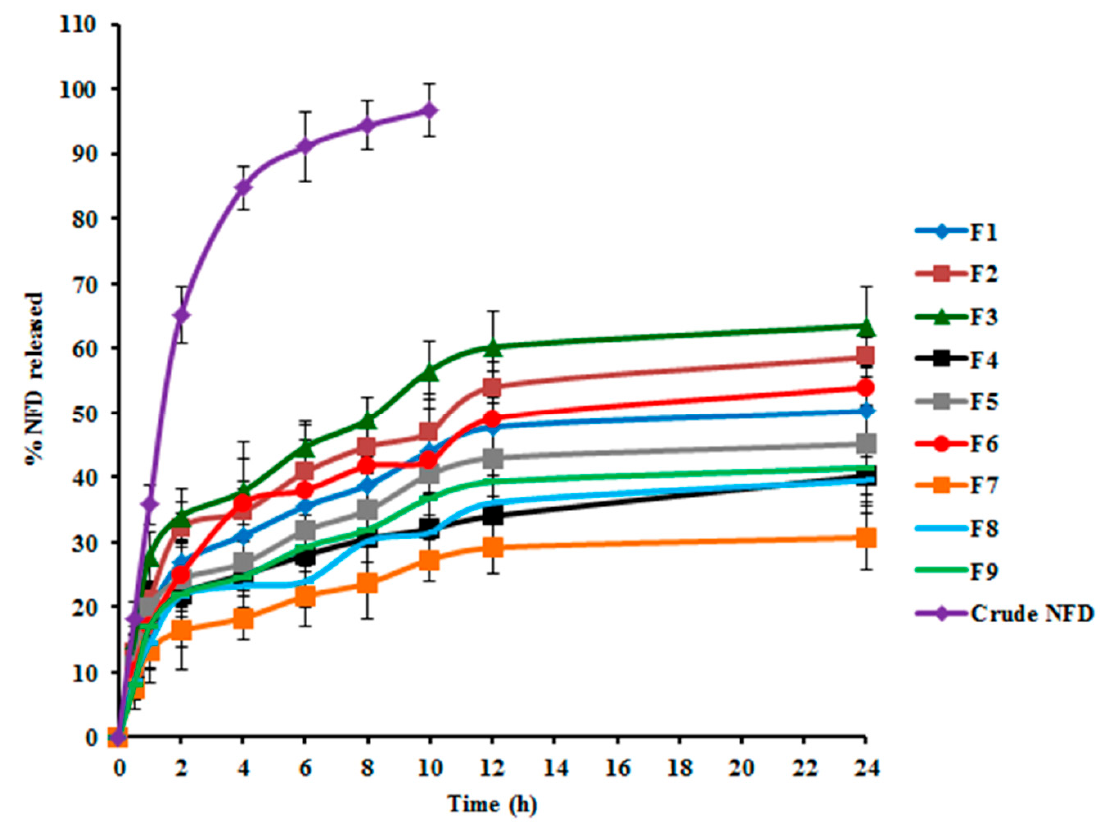
Figure 2. NFD in vitro release profiles from NFD suspension and various NFD-CTS-PLGA nanocomposites formulations.